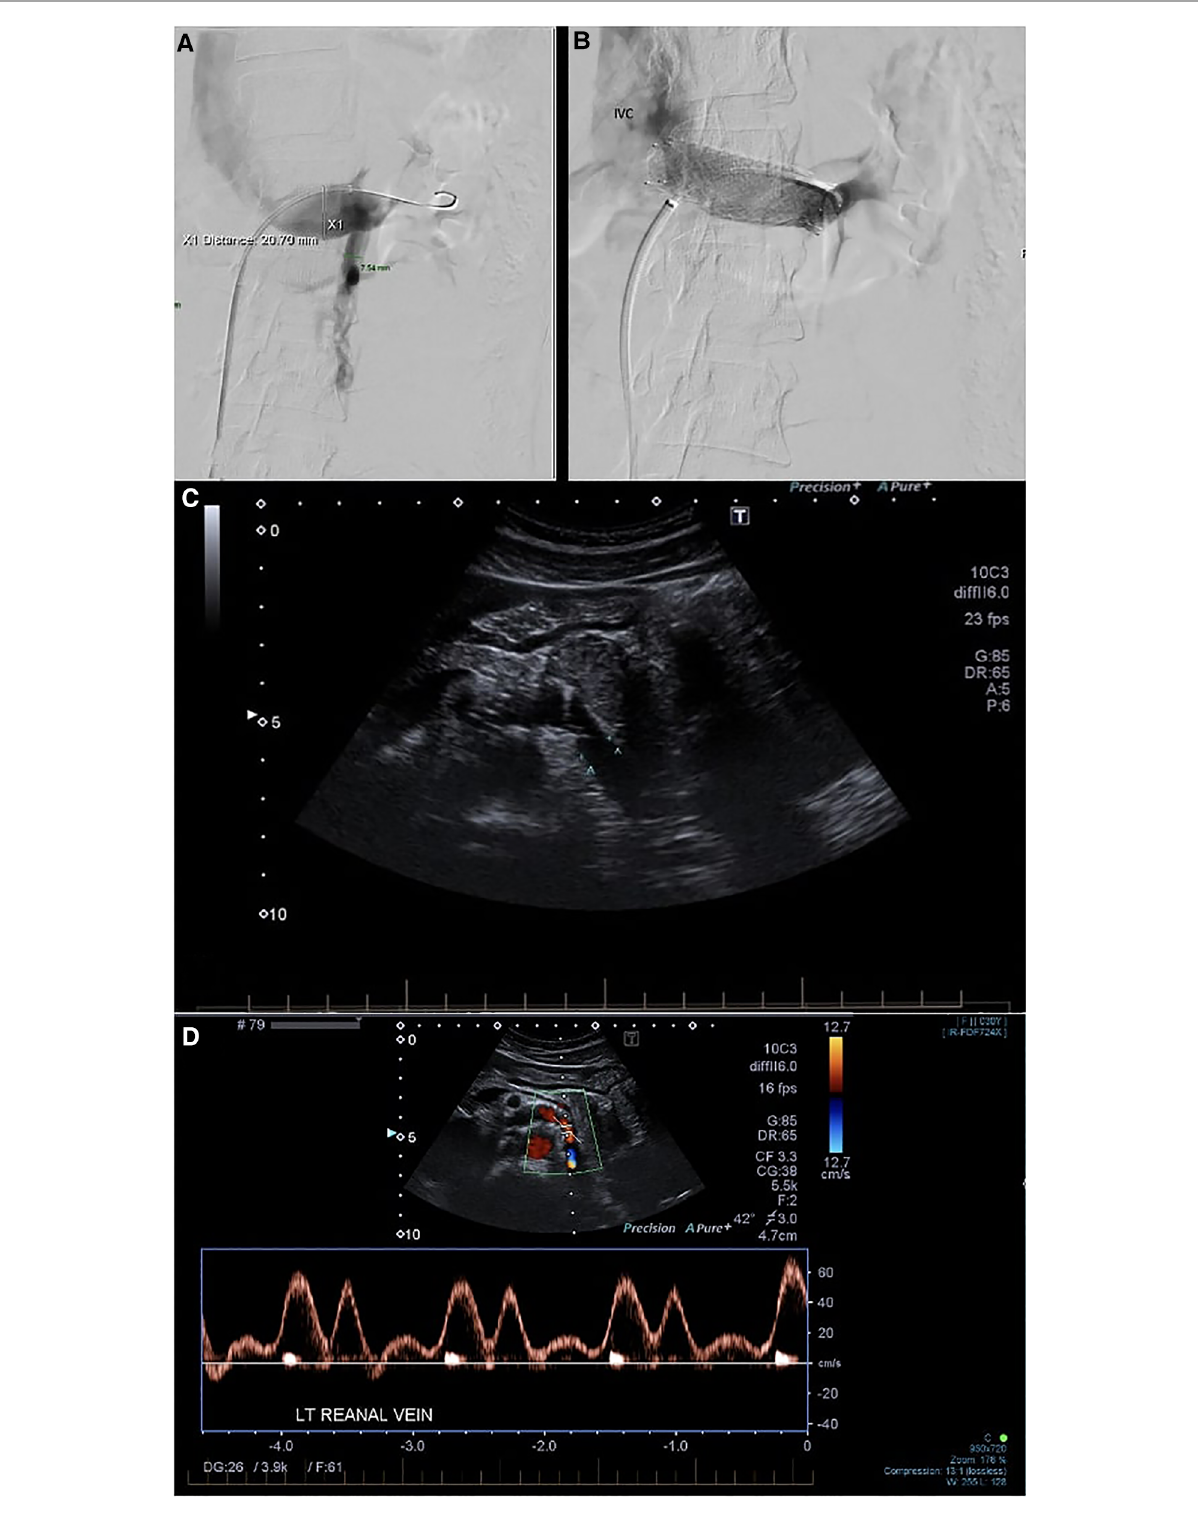
FIGURE 2 ( A ) Phlebography demonstrating stenosis of the LRV with re fl ux into the LOV. ( B ) Venogram after stent deployment. Re fl ux into the left ovarian vein is no longer seen. The distal part of the stent is somewhat constrained, but the proximal part prolapses into the IVC. ( C ) Follow-up duplex ultrasound at 3 months. ( D ) Post-procedure LRV duplex velocities and assessment of velocity ratio. IVC, inferior vena cava; LRV, left renal vein; LOV, left ovarian